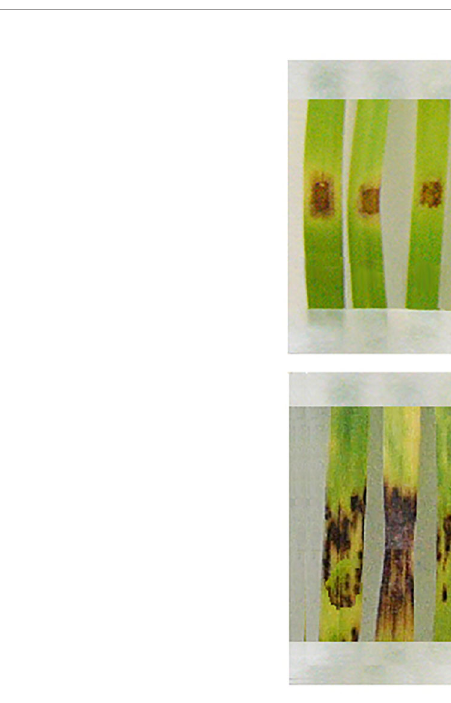
FIGURE 4 | Disease symptoms on fragments of detached wheat leaves inoculated with the Folicur ® -resistant strain, m8-4 (A) , or the Folicur ® -susceptible, wild strain of P. nodorum , M-4 (B) . Conidial suspensions applied at a fi nal concentration of 10 6